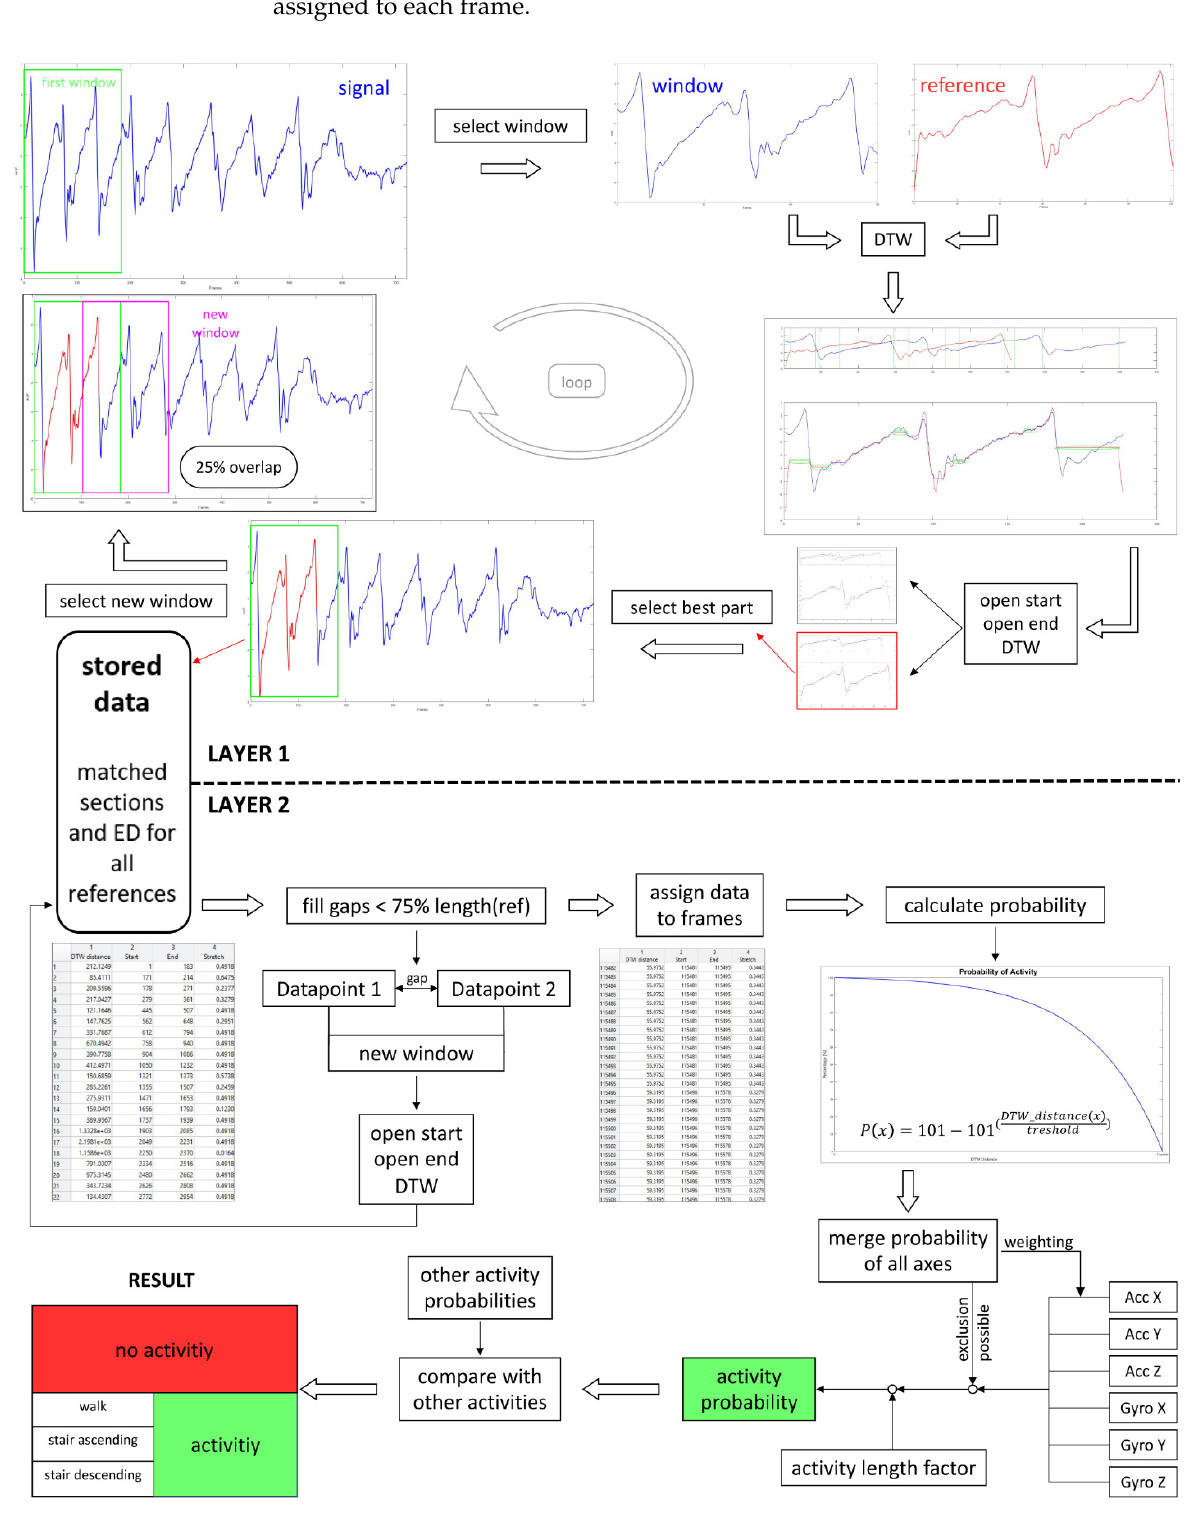
Figure 3. Flowchart of the locomotion recognition process.